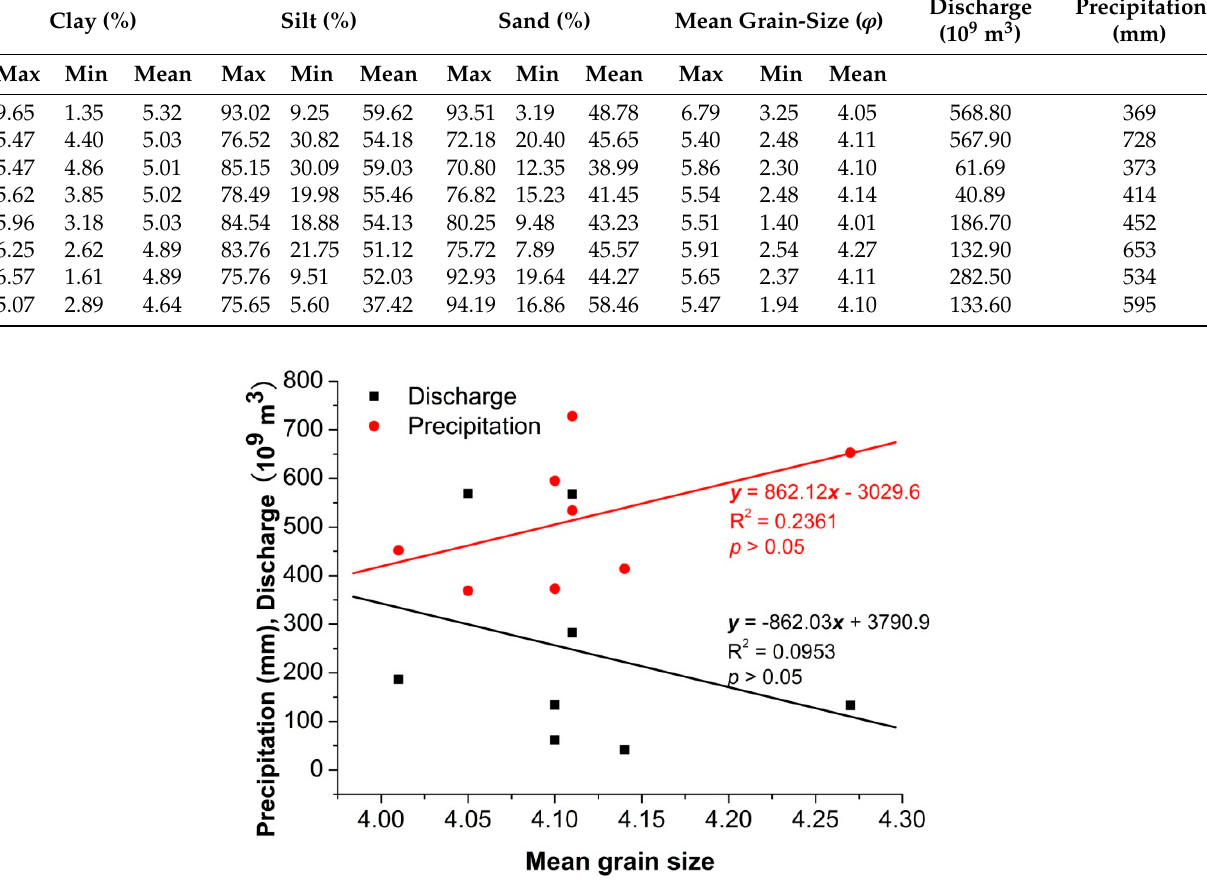
Figure 12. Changes in the mean grain-size from 1989 to 2015 along with the discharge of the Yellow River and precipitation.